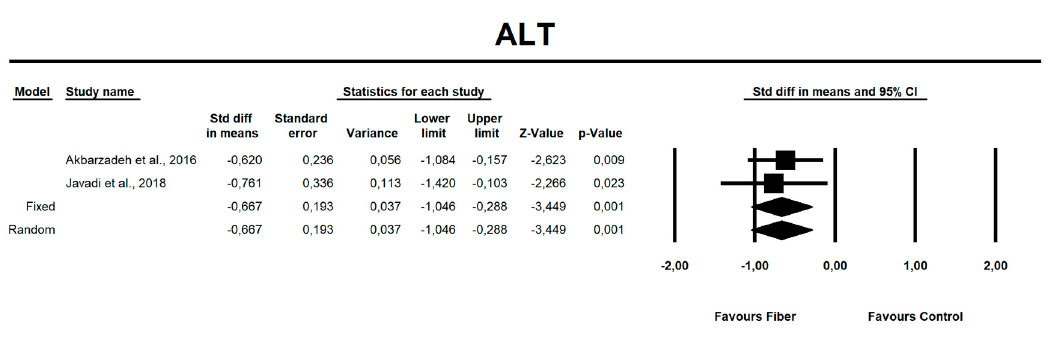
Figure 7. Effect size and standardized mean difference (SMD) for aspartate aminotransferase (AST) in people supplementing fiber vs. controls. Q = 0.958, df(Q) = 1, p = 0.328, I-squared = 0.0. Figure 8. Effect size and standardized mean difference (SMD) for insulin in people supplementing fiber vs. controls. df(Q) = 1, p = 0.864, I-squared = 0.0.